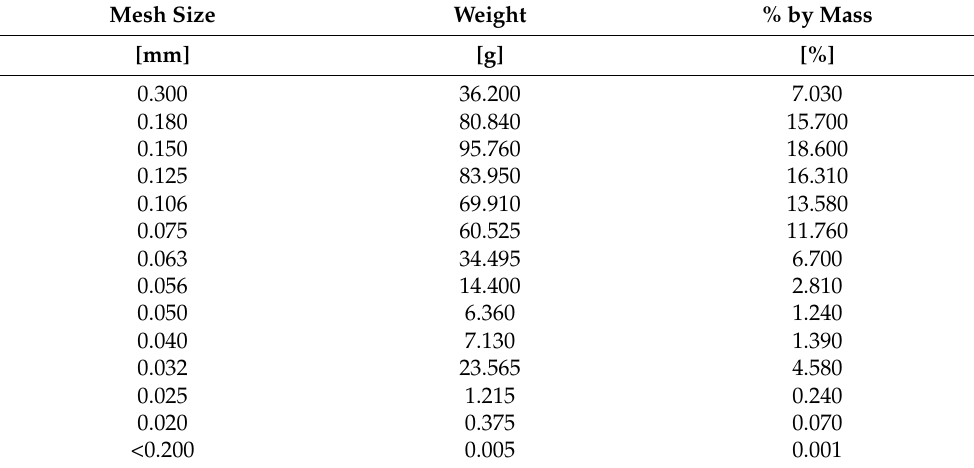
Table 4. Results of granulometric analysis for basalt